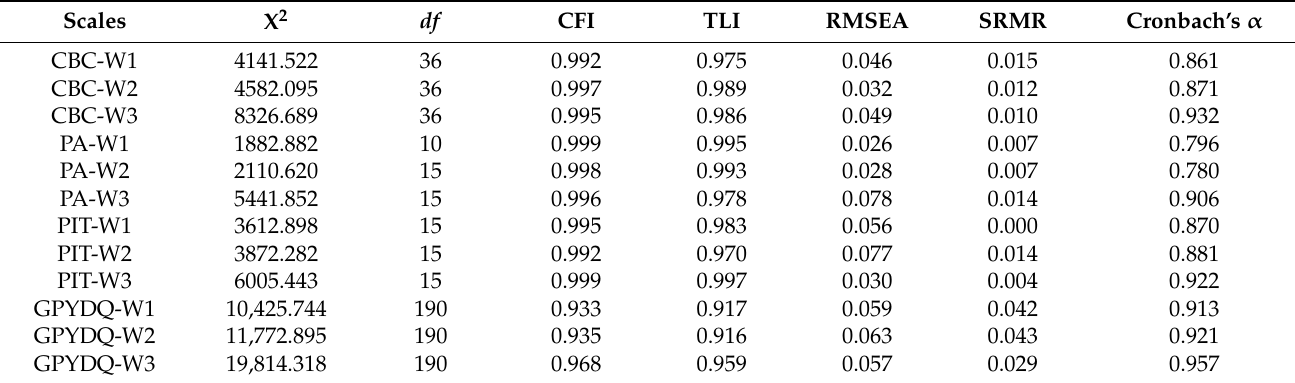
Table 1. Psychometric characteristics of